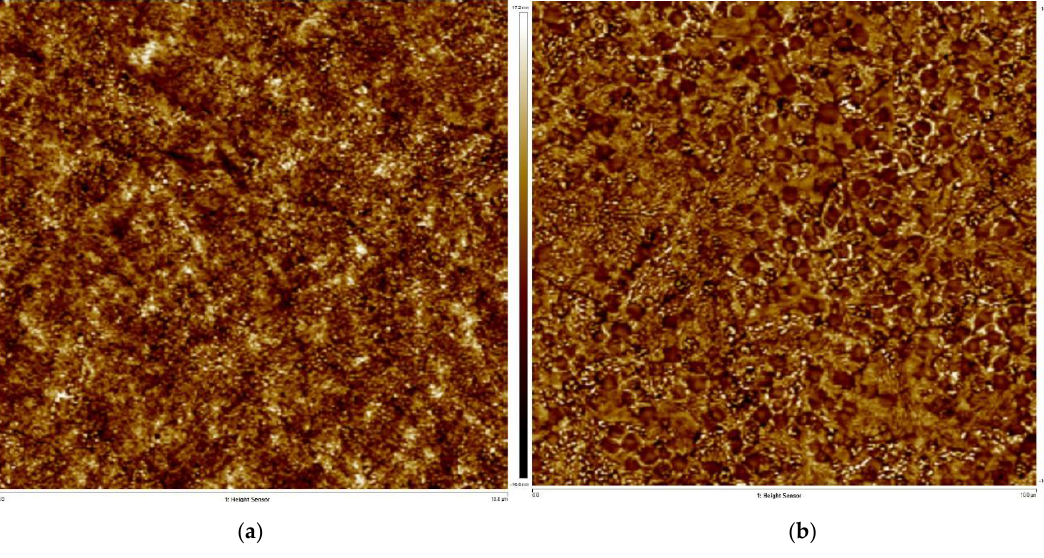
Figure 3. ( a ) Atomic force microscope (AFM) image of CsPbBr 2.5 I 0.5 film without PAN; ( b ) AFM image of CsPbBr 2.5 I 0.5 film with PAN.